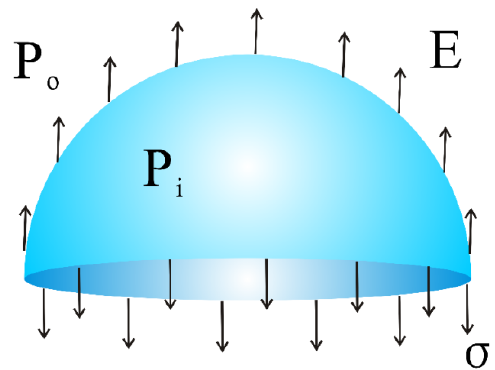
Figure 2. The force analysis model of the bubble during critical bubble electrospinning.